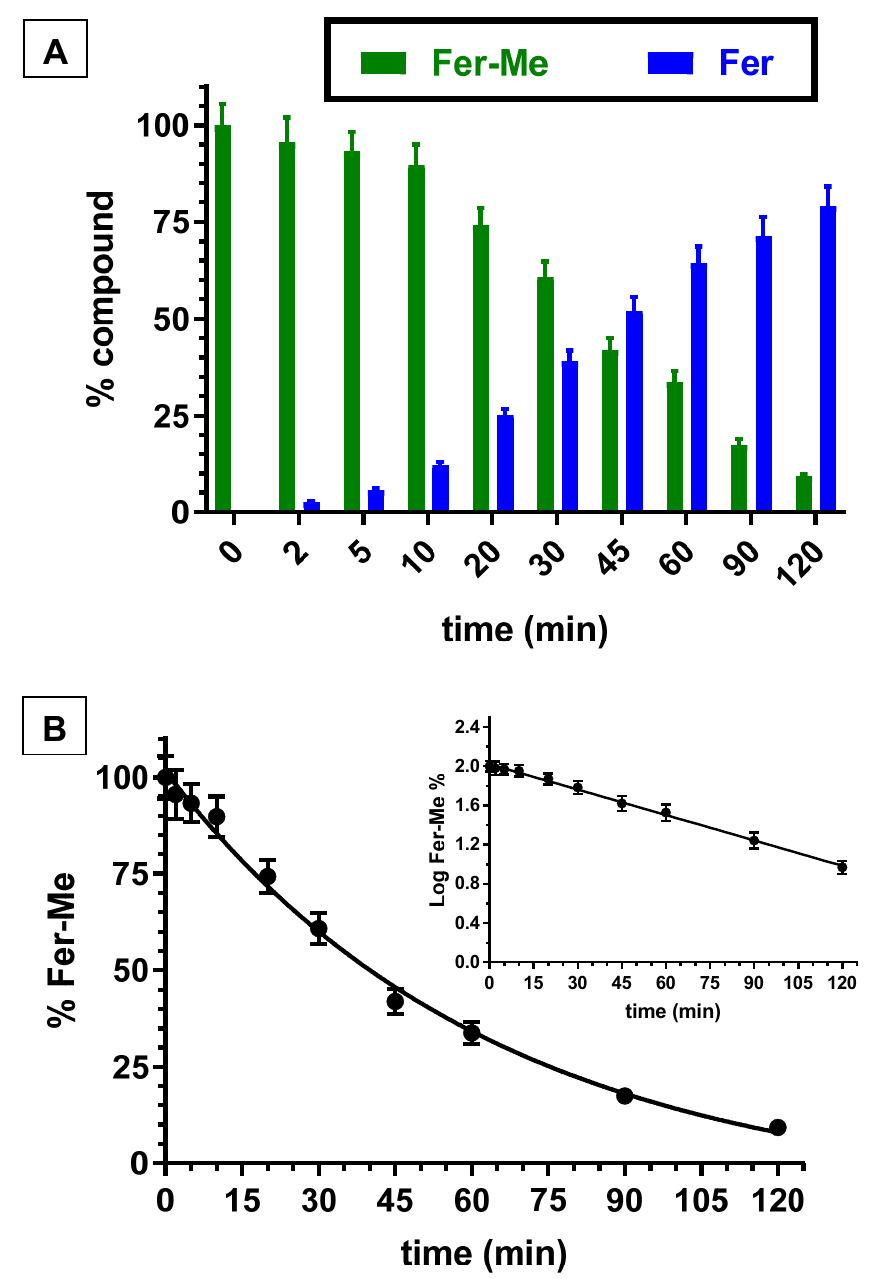
Figure 3. ( A ) Degradation profiles of the prodrug Fer-Me (green) and the corresponding appearance profiles of Fer (blue) in rat liver homogenate. All the values are reported as the percentage of the overall amount of incubated. Data are reported as the mean ± S.E.M. of three independent experiments. ( B ) Degradation profile of the prodrug Fer-Me in rat liver homogenate. Data are expressed as the mean ± S.E.M. of three independent experiments. The degradation followed a pseudo first order kinetic, confirmed by the semilogarithmic plot reported in the inset (n = 10, r = 0.998, p < 0.0001). The half-life of Fer-Me was calculated to be 34.7 ± 1.6 min.